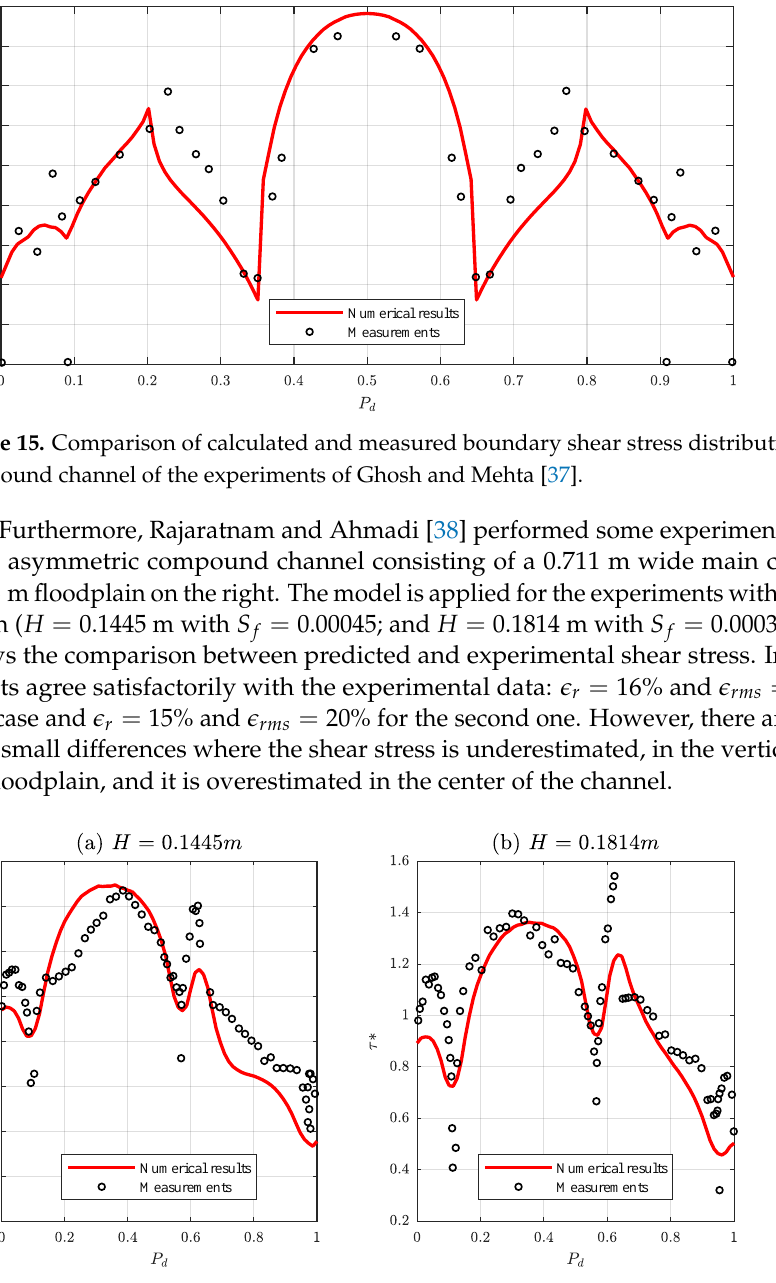
Figure 16. Comparison of calculated and measured boundary shear stress distributions in a com- pound channel of the experiments of Rajaratnam and Ahmadi [38]: ( a ) H = 0.1445 m; and ( b ) H = 0.1814